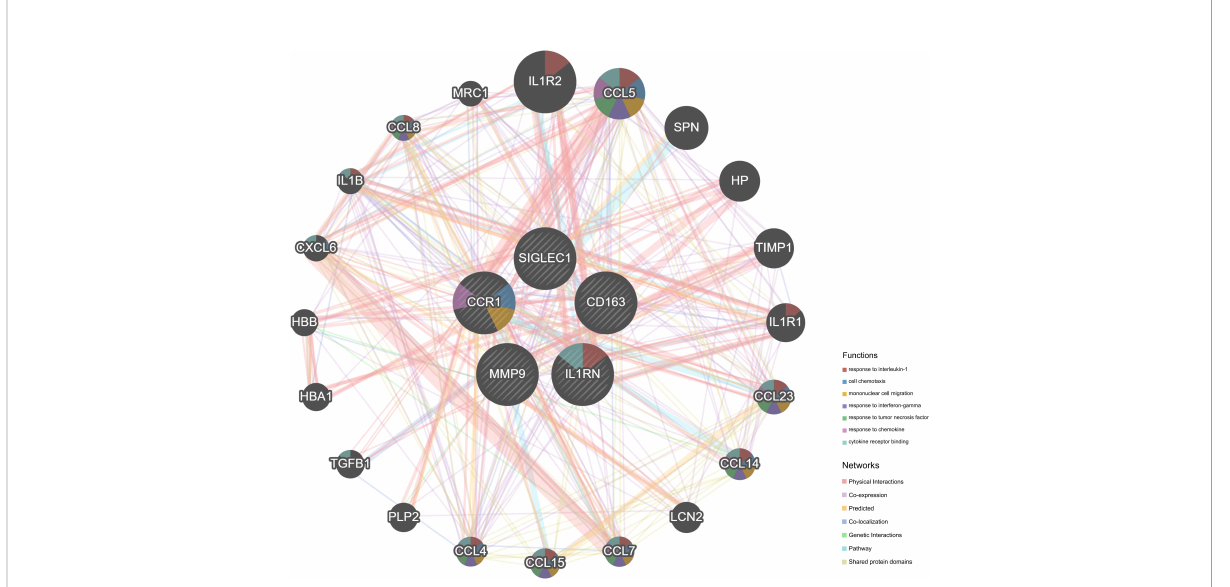
FIGURE 5 Five HGs and their co-expression genes analyzed using GeneMANIA.